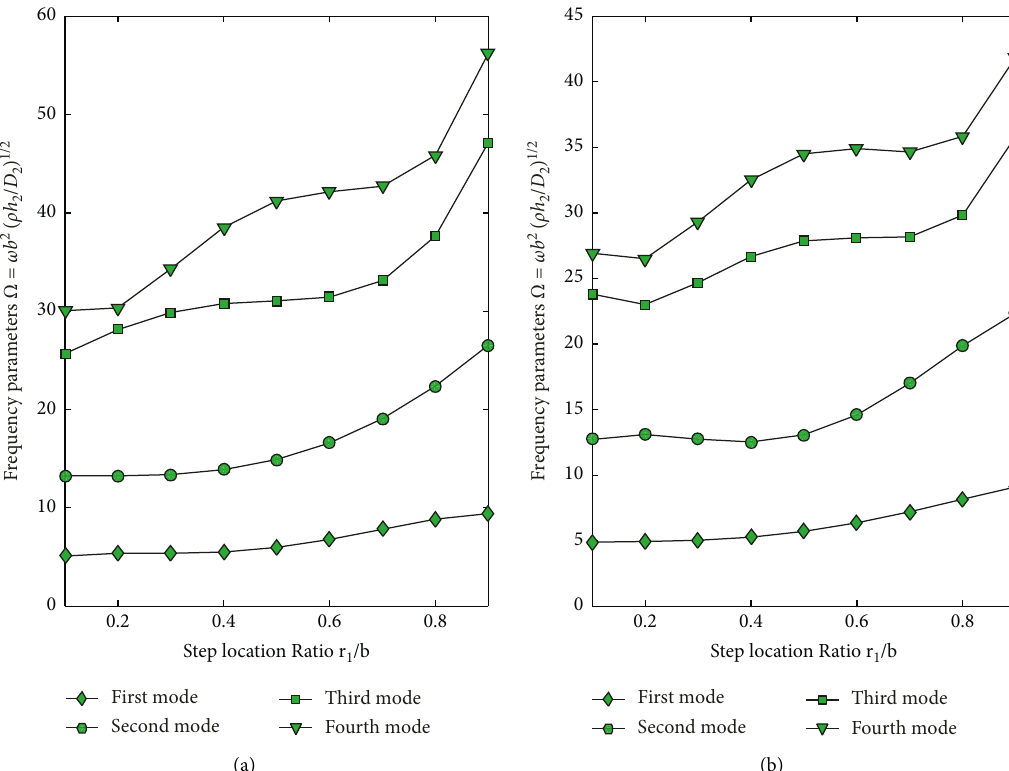
������ 􏽰 ρ h versus step location ratio r / D 2 2 / b � (a) 0.006 and (b) 0.15. 1